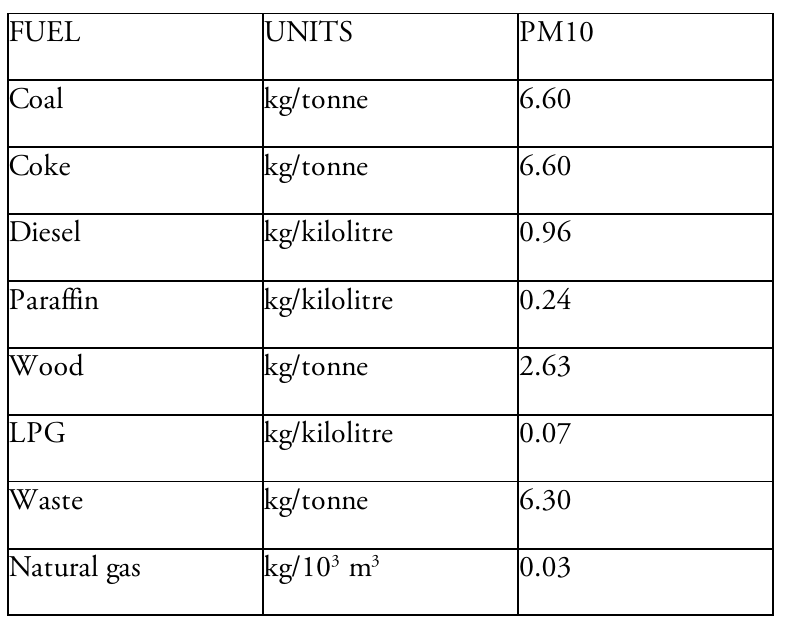
Table 10: PM10 emission factors for industrial, commercial and institutional fuel combustion